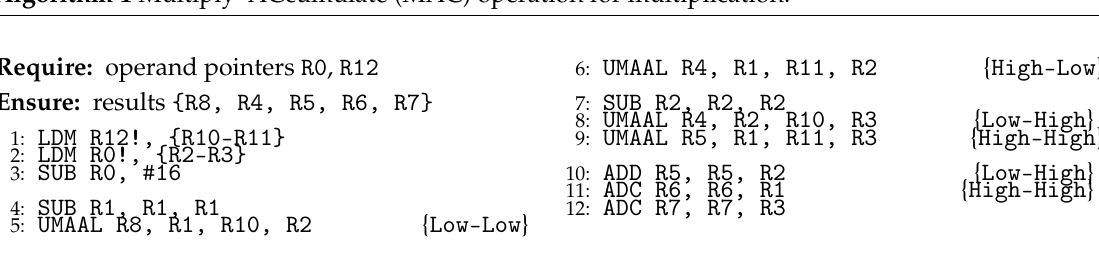
Algorithm 1 Multiply–ACcumulate (MAC) operation for multiplication.